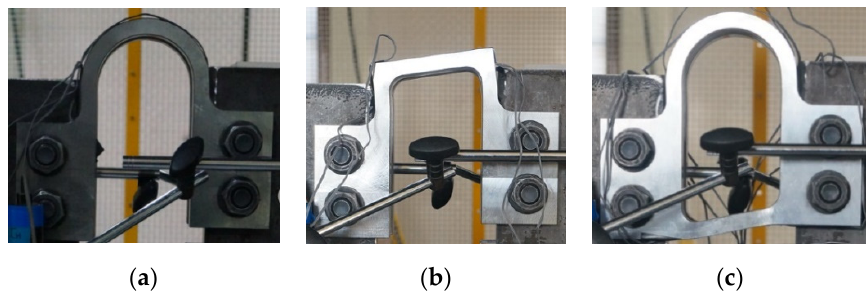
Figure 5. Deformation of steel dampers at target displacement: ( a ) SD1; ( b ) SD2; ( c ) SD3.